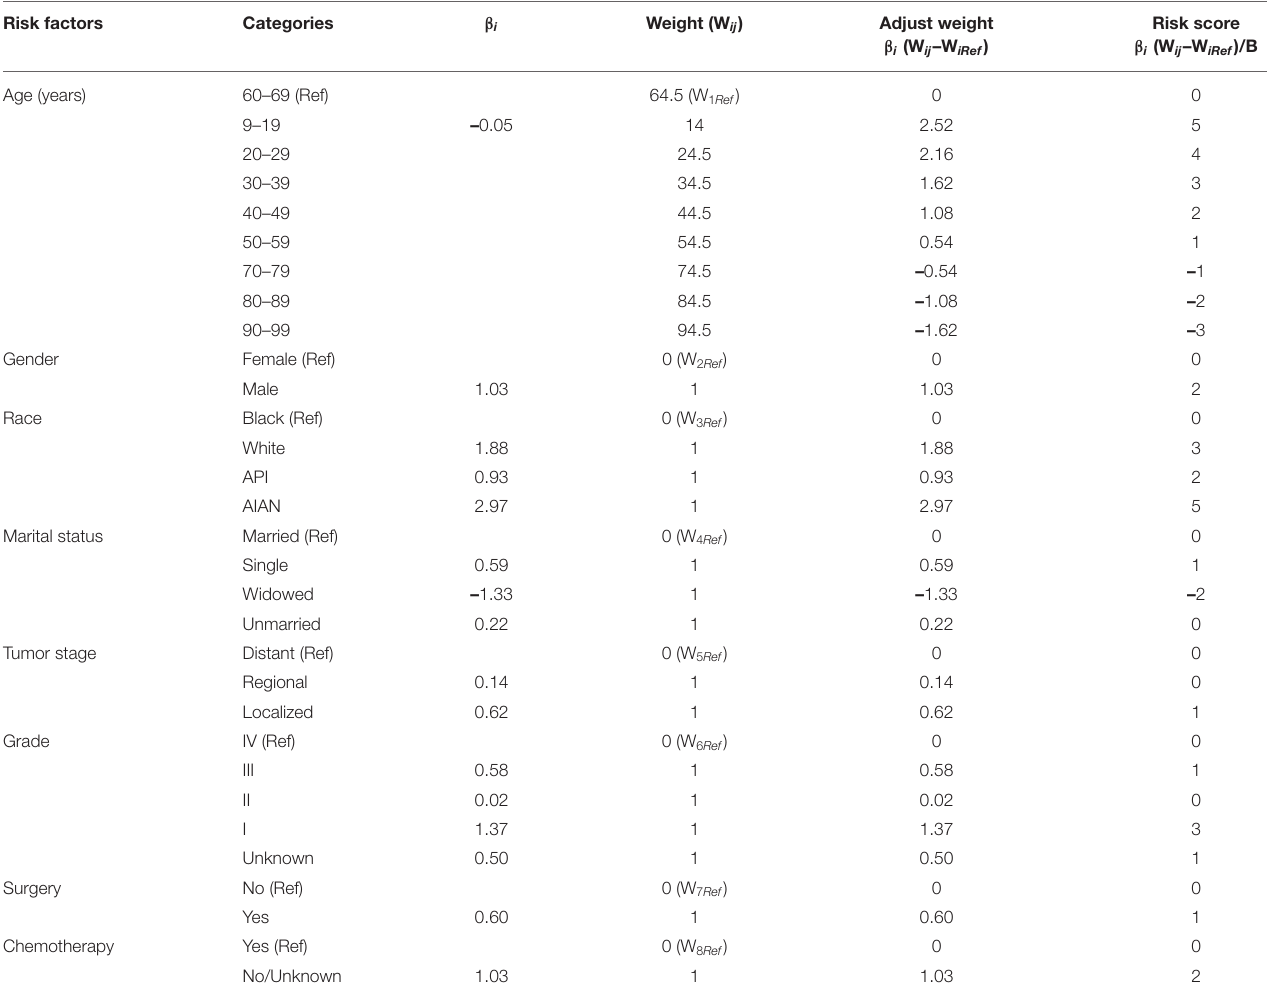
TABLE 3 | Risk score of NEN cases in the training data